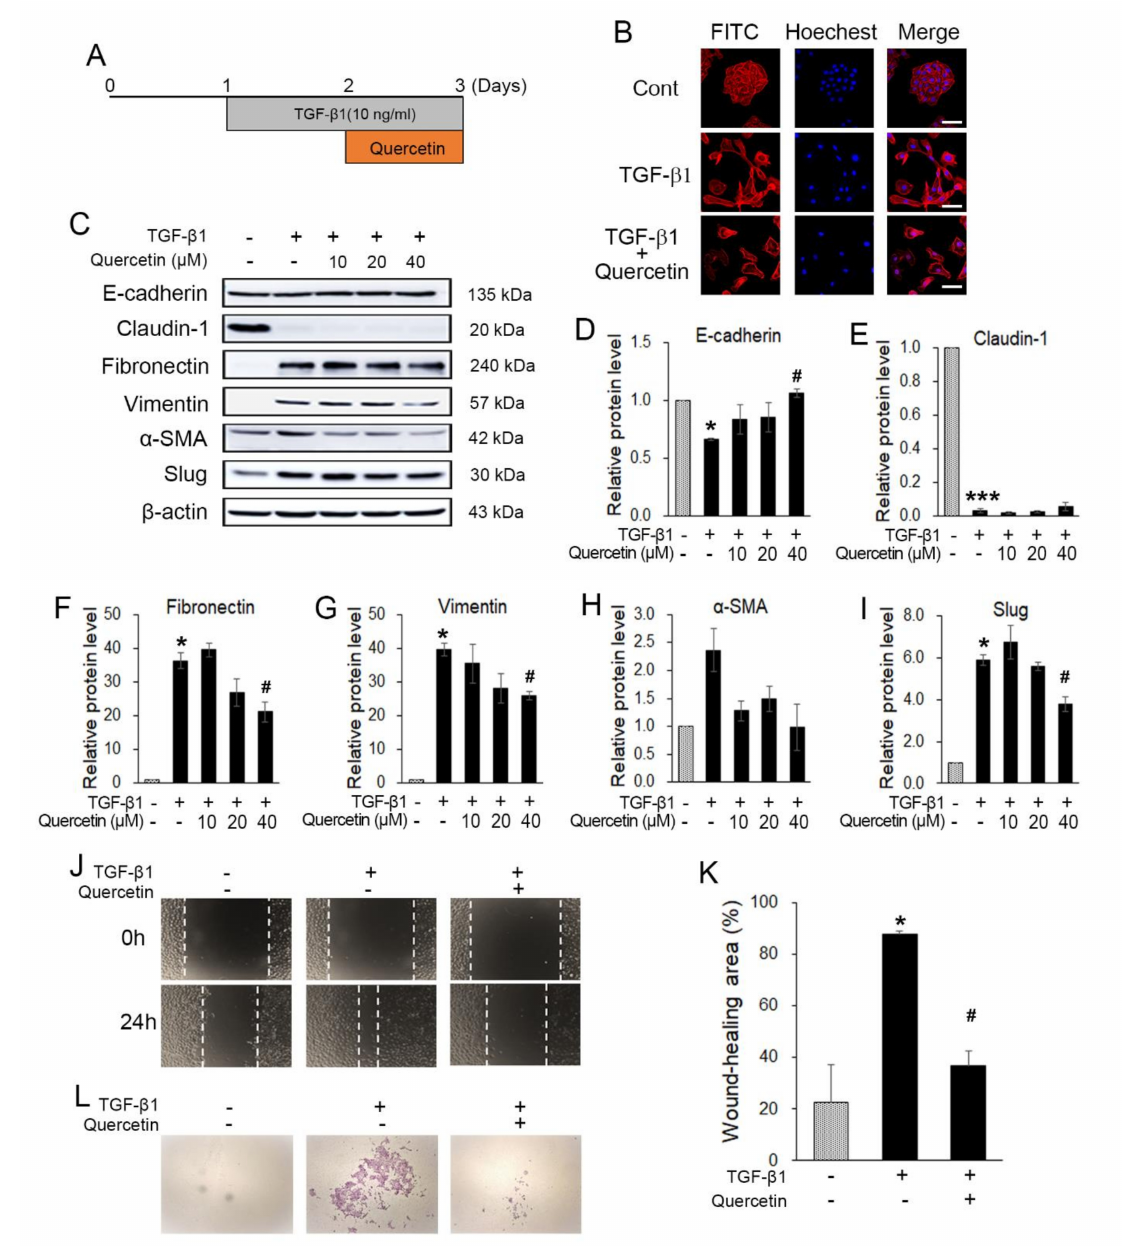
Figure 6. Quercetin inhibited TGF- β 1-induced EMT. ( A ) Experimental setup. ( B ) Western blot results showed that quercetin also regulated TGF- β 1-induced EMT markers. ( C ) Treatment of TGF- β 1 also changed the morphology of HaCaT. Further, quercetin induced morphological recovery. Scale bars: 50 µ M. ( D – I ) Quantification of hRPTECs viability by MTT assay. ( J , K ) A wound-healing assay was conducted to evaluate the TGF- β 1-induced EMT migration ability; quercetin attenuated EMT-induced migration in HaCaT cells. ( L ) Quercetin inhibited the invasion capacity of EMT-induced HaCaT cells. Data are the means ± SEM. * p < 0.05, and *** p < 0.001 vs. the corresponding control (without TGF- β 1 and quercetin); # p < 0.05 vs. the corresponding control (with TGF- β 1 and without